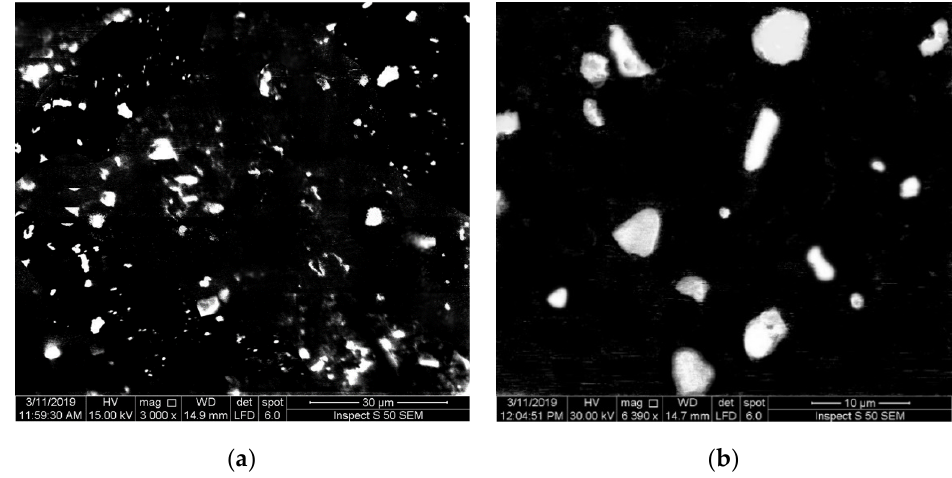
Figure 2. SEM monograph of 0.01 w / v PMMA-TiO 2 samples ( a ) 0.05 and ( b ) 0.1 wt.